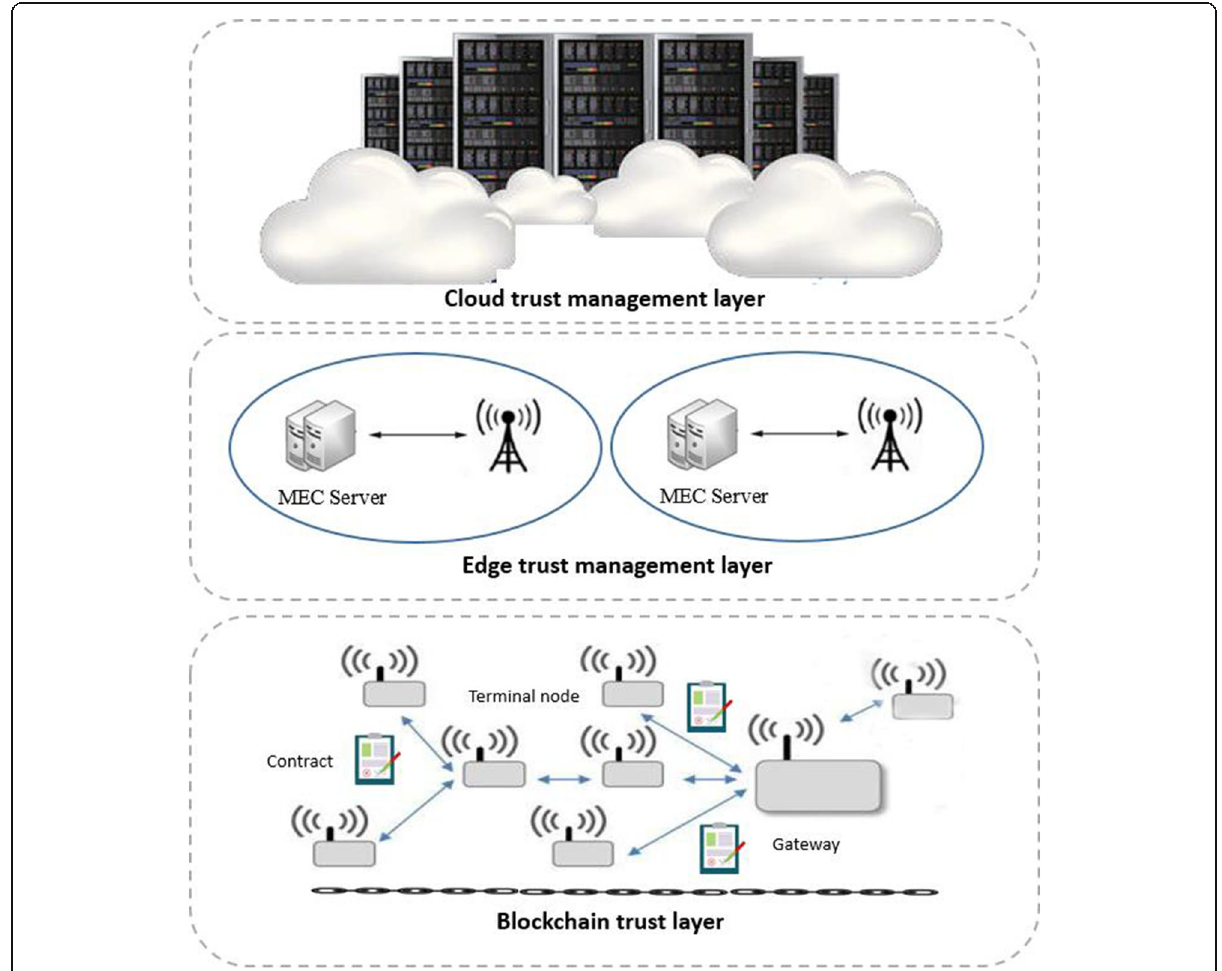
Fig. 21 Cloud-edge-end hybrid trust management